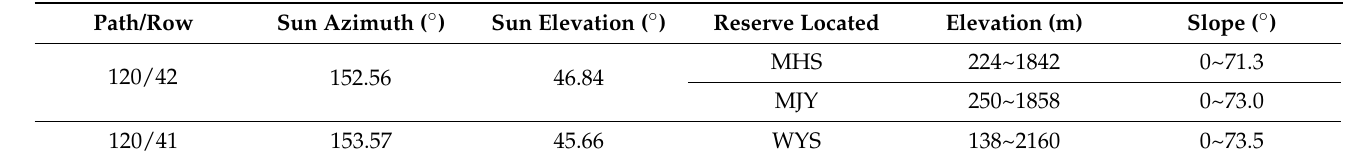
Figure 1. Location of the three protected areas: The Meihuashan National Nature Reserve (MHS), Minjiangyuan National Nature Reserve (MJY), and Wuyishan National Park (WYS) (red shapes), sample areas (red points), and samples (yellow points) in two scenes of Landsat 8 Operational Land Imager (OLI) images (Path/Row of 120/41 and 120/42, red – green – blue (RGB) composite). Table 1. Solar angles of Landsat 8 OLI images and topographic factors of the protected areas of MHS, MJY and WYS.